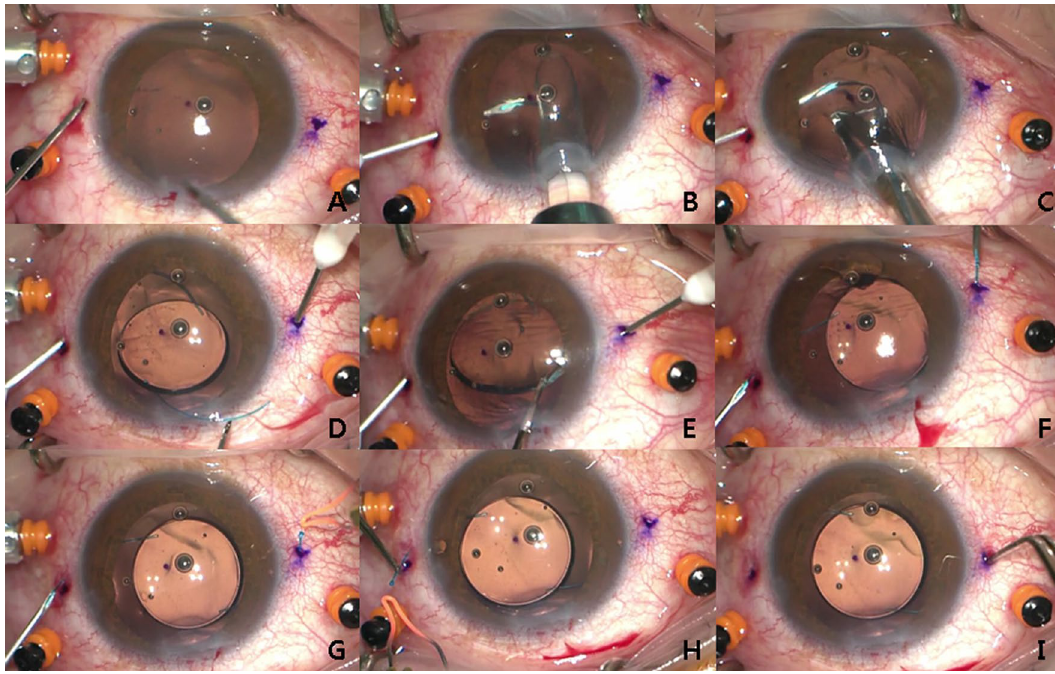
Figure 1. Intraoperative photographs showing the Simply Modified Intrascleral Fixation Using Round Flange (SMURF) technique. ( A ) After a pars planar vitrectomy, a 2.75 mm clear corneal incision was made in the 12 o’clock to 1 o’clock direction for intraocular lens (IOL) insertion. An oblique sclerotomy was performed 2.0 mm from the limbus using a conventional 27-gauge needle. ( B ) A leading haptic was directly placed into the lumen of the first needle without the use of forceps after the leading haptic was injected into the anterior chamber. ( C , D ) The entire optic was injected into the anterior chamber, leaving the trailing haptic at the corneal wound, after placement of the leading haptic into the first needle. ( D ) A second oblique sclerotomy was performed with the same technique and the same conventional 27-gauge needle. ( D , E ) The trailing haptic was grasped 3–4 mm from the end of the haptic with intraocular forceps and was simultaneously inserted into the anterior chamber and the lumen of the second needle. ( F ) The haptics were externalised with the two 27-gauge needles. ( G , H ) The ends of the haptics were cauterised to create flanges. I. Both flanged ends of the haptics were buried intrasclerally. The images showed good centring of the IOLs after the